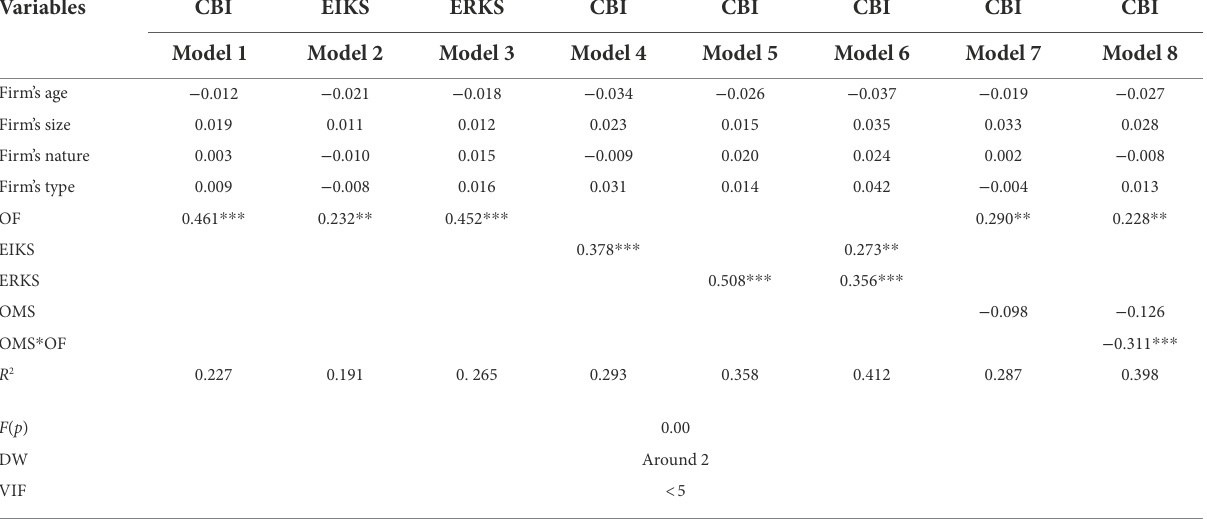
TABLE 5 Hierarchical regression analysis.